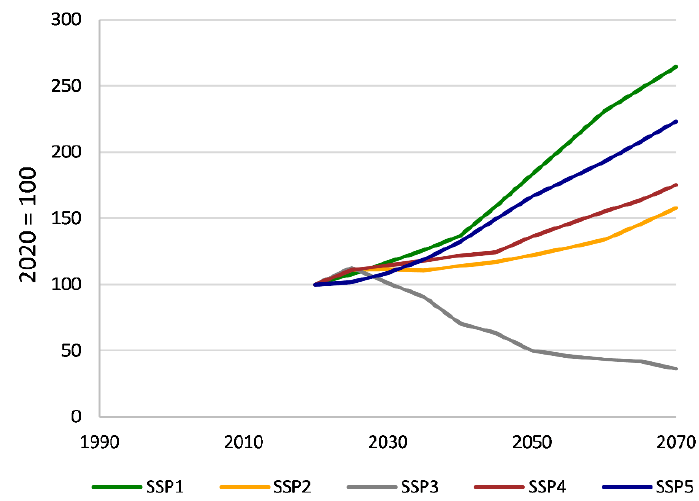
Figure 11. Global price of wood pellets across SSPs, 2020 to 2070 projections from FOROM.